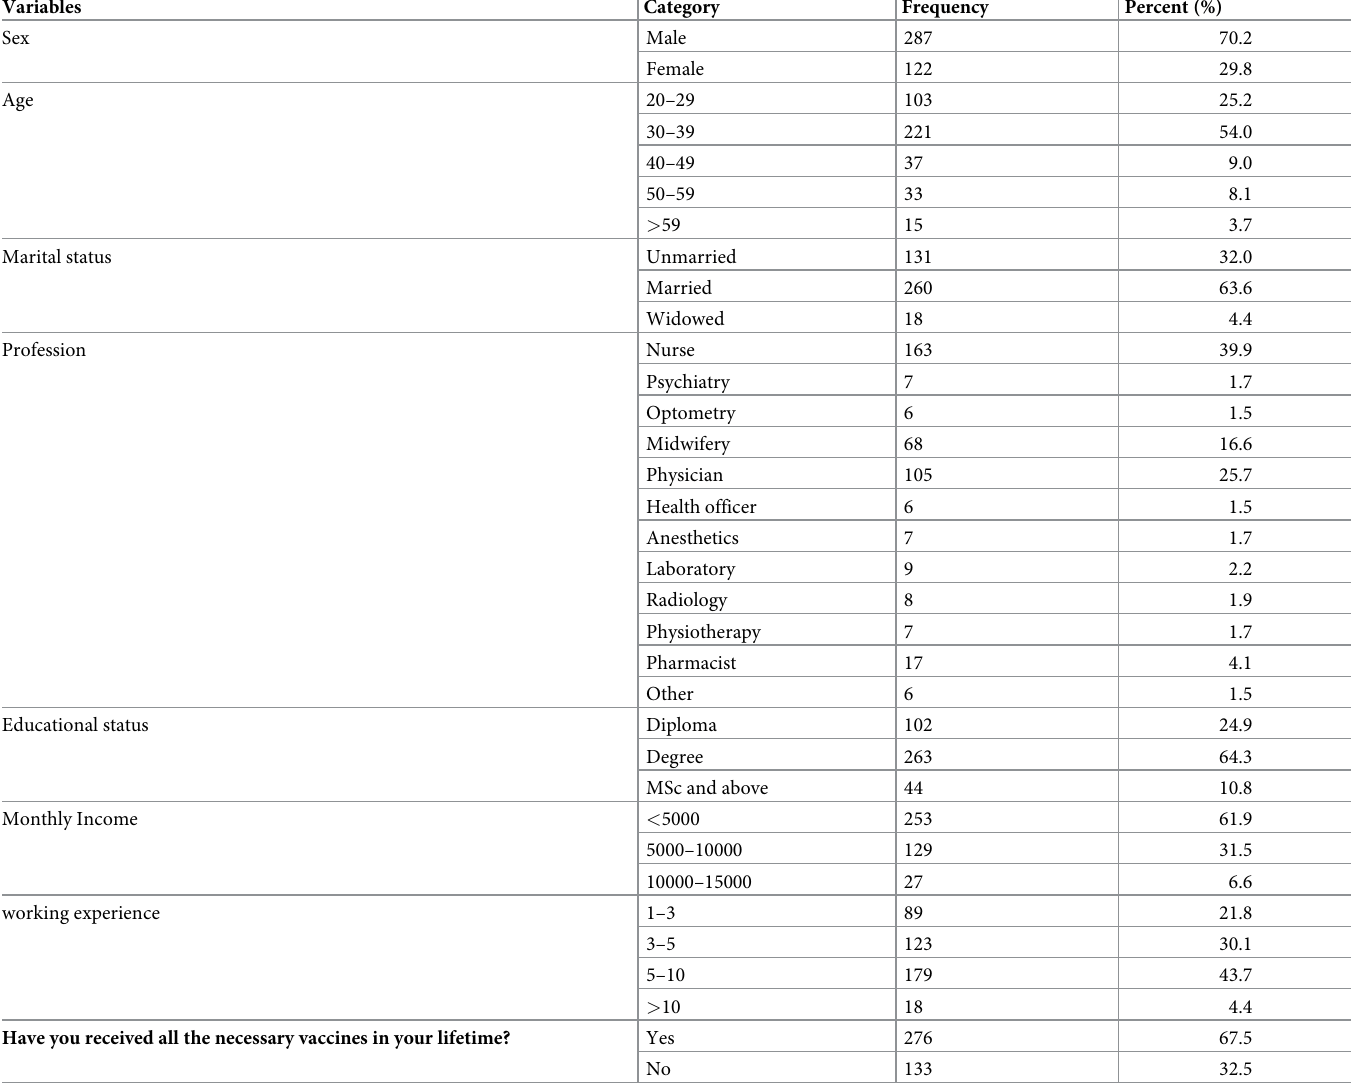
Table 1. Socio-demographic characteristics of intention to receive vaccine against COVID-19 among health professionals at selected hospitals in south-west, Ethio- pia, 2021. Variables